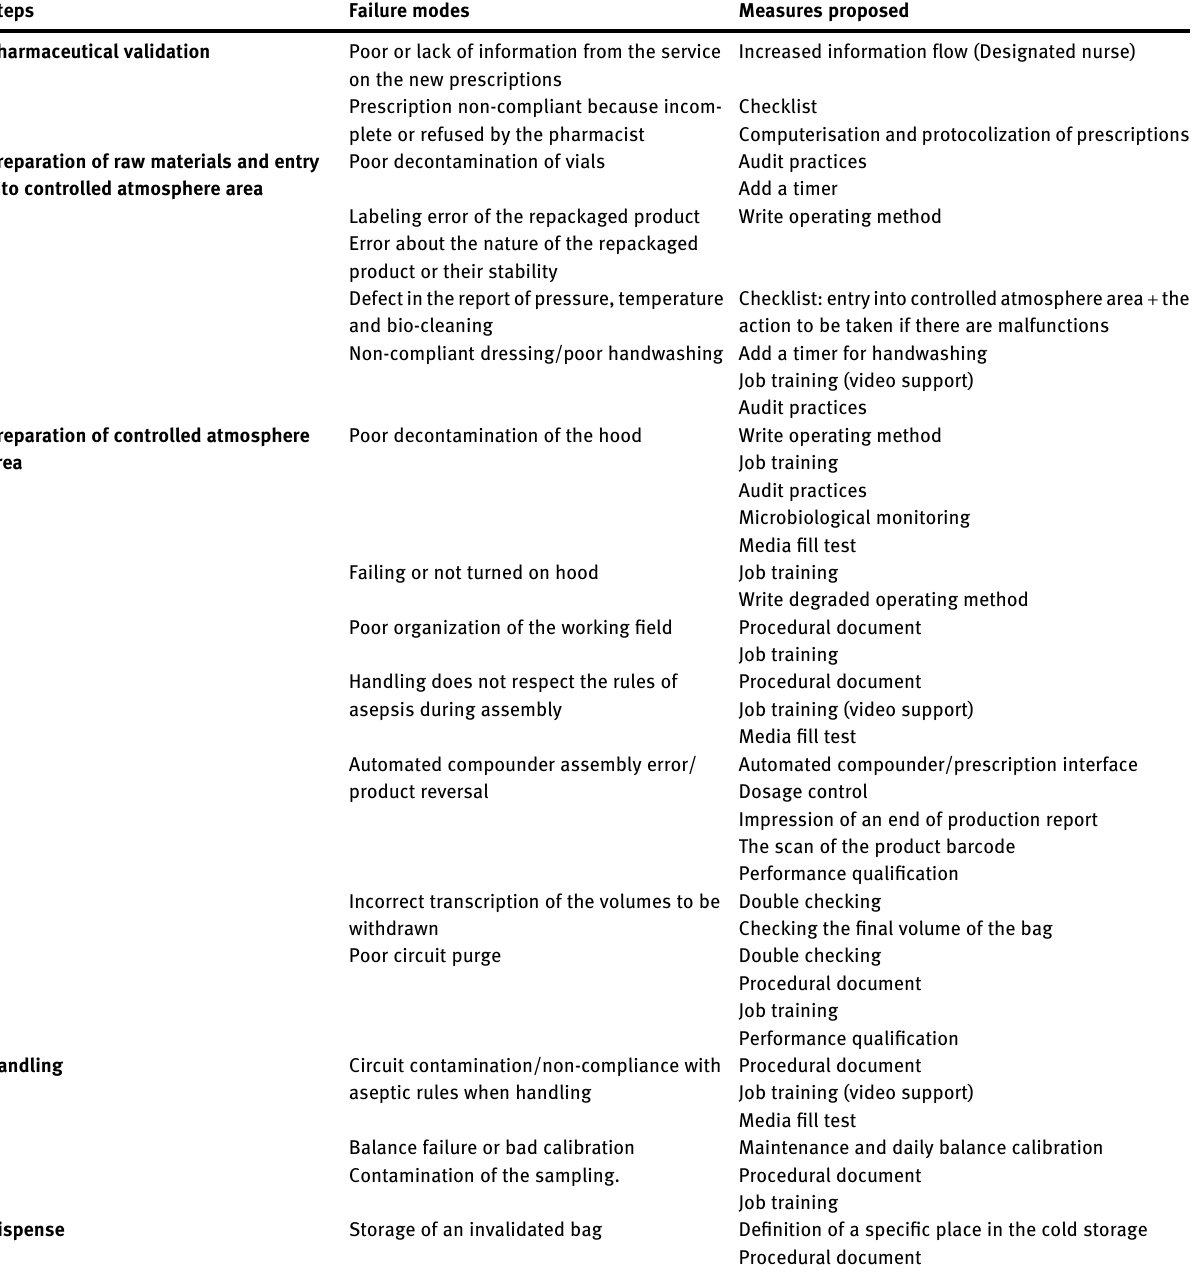
Table  : The measures proposed for the most critical failure modes de fi ned in FMECA.